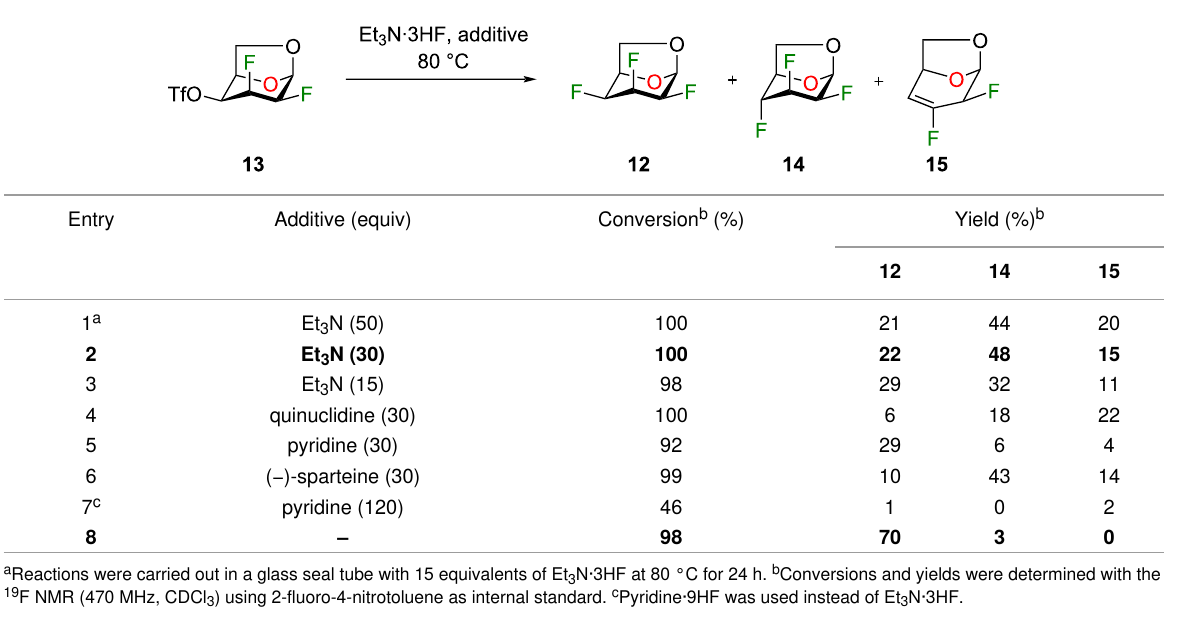
Table 2: Selective synthesis of trifluorotalose analogue 12 or trifluoromannose analogue 14 using Et 3 N·3HF. a